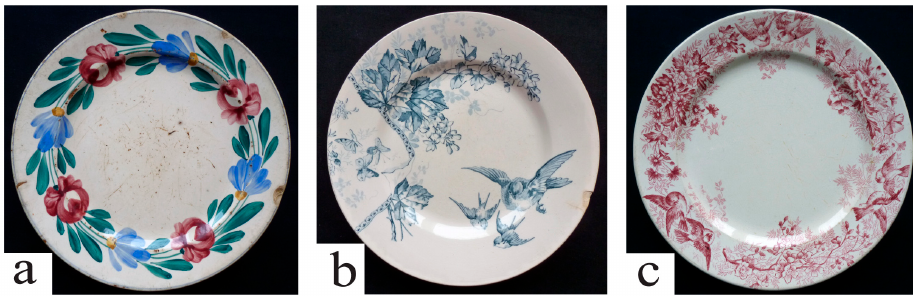
Figure 13. A selection of Swiss CaO-poor objects from the Musée de Carouge. ( a ) Plate. Impressed marks “IVO” and the number “5”. Picolas & Neuenschwander manufactory, Carouge, 1880. D.: 23.8 marks “IVOIRE”, “D & C” and the number “5”. Charles Degrange & Cie. manufactory, Carouge,